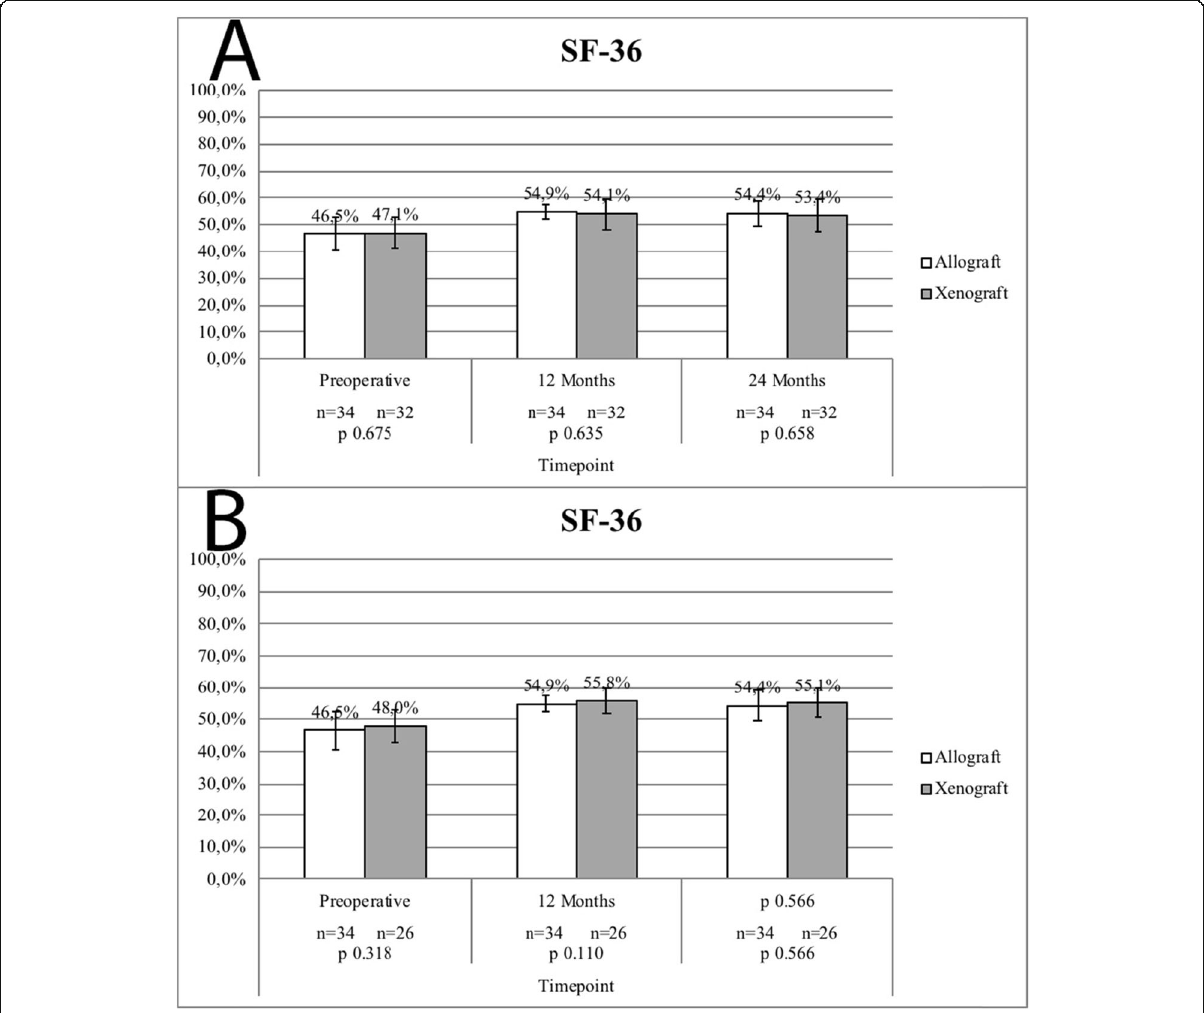
Fig. 4 SF-36 Scores - a , Missing/Contaminated Graft Subjects Included (LOCF); b , Missing/Contaminated Graft Subjects Excluded. No statistically significant differences were reported between study groups in both analysis (intention-to-treat vs. per